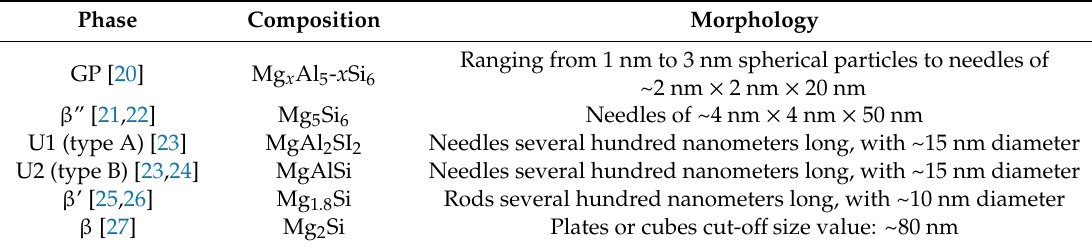
Figure 8. TEM morphology of precipitate phases ( a ) T6; ( b ) 200 °C; ( c ) 300 °C; ( d ) 400 °C. Table 1. Overview of observed precipitation phases in Al-Mg-Si alloy.